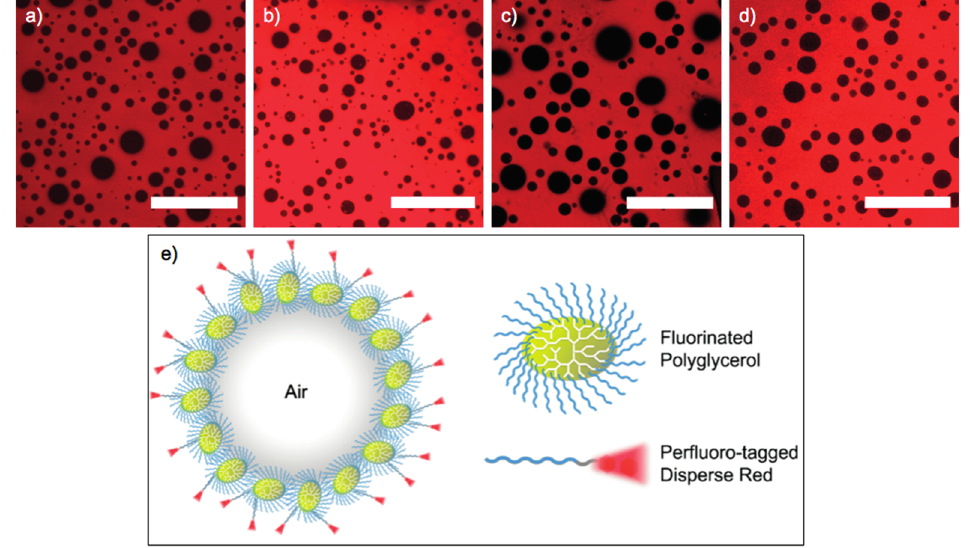
Figure 2. Fluorescence images of dichloromethane solutions containing Nile Red, PLA, and porogens: ( a ) hPG 7.5kDa100 ; ( b ) hPG 13kDa100 ; ( c ) dPG [G3.5] ; and ( d ) hPG 7.5kDa50 . Scale bar: 50 µm. Microbubbles appear as black circles; and ( e ) Schematic of a stabilized microbubble formed through the self-assembly of F-hPG and